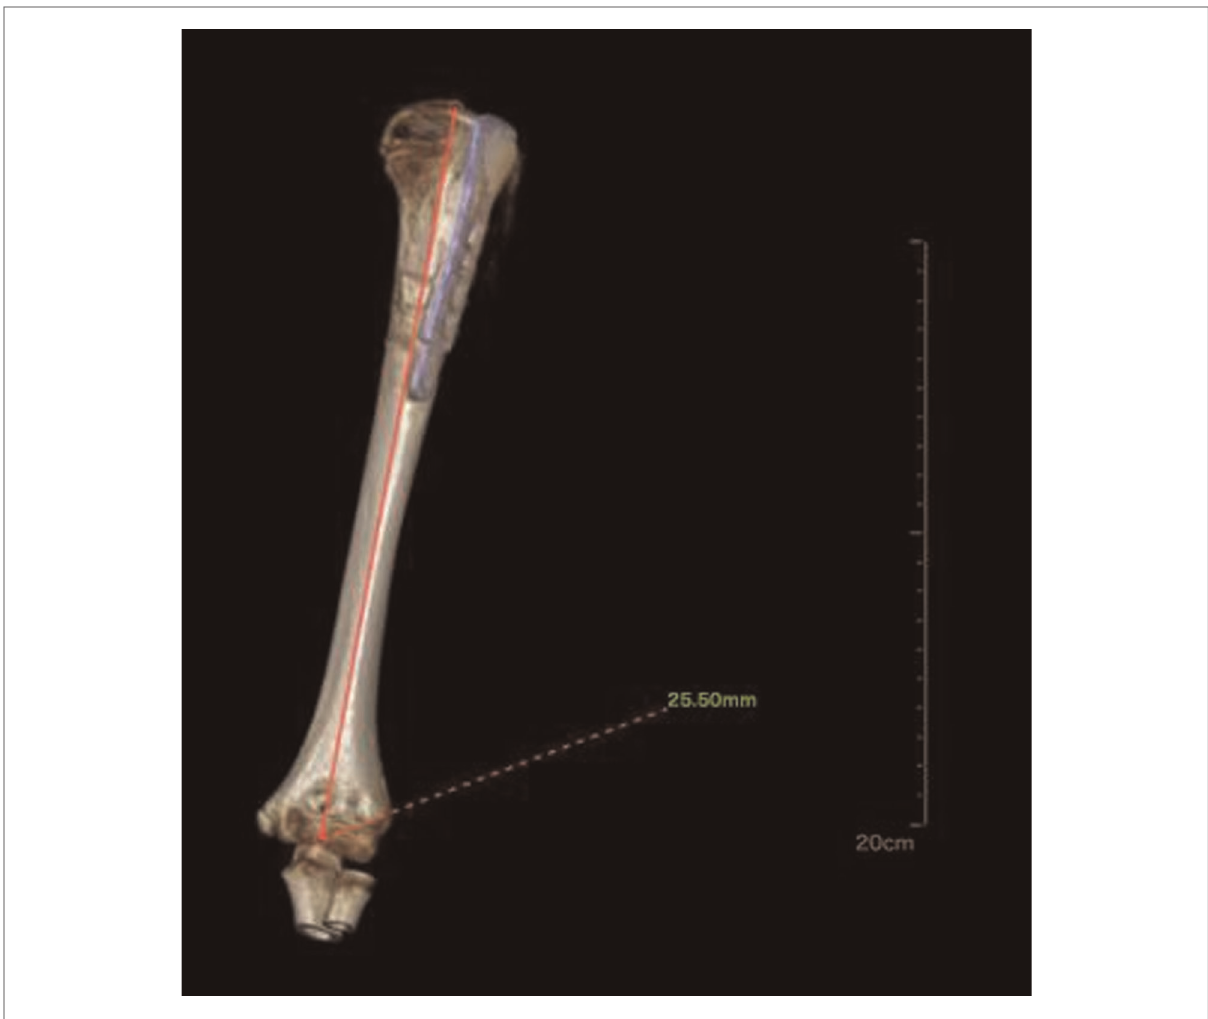
FIGURE 4 Measurement results of the length of the affected